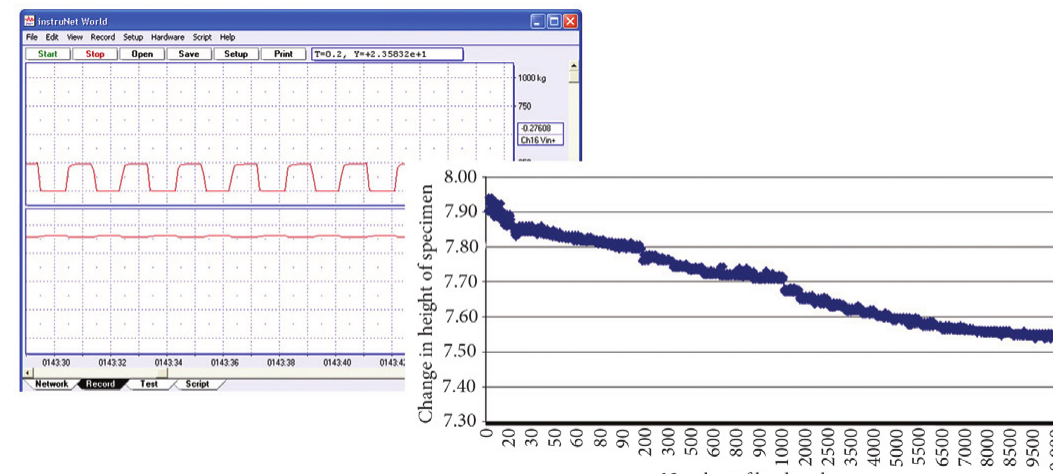
Fig. 3. Example of record of loading and record of sample